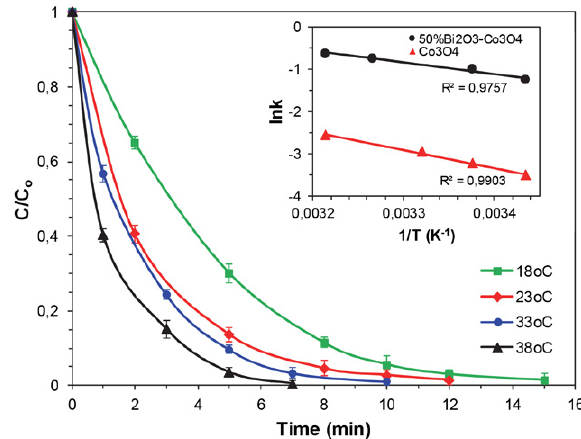
Fig. 14. Effect of reaction temperature on AO7 degradation by 50%